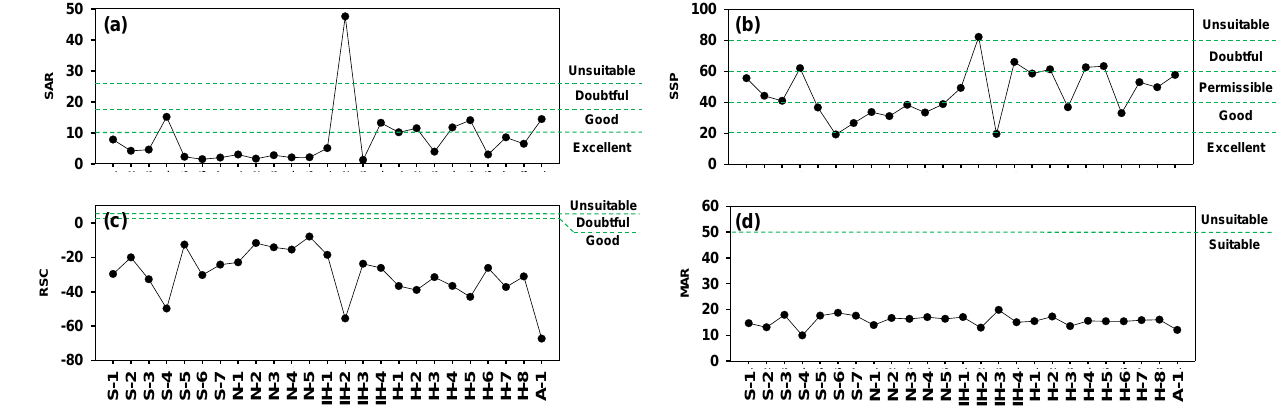
Figure 5. Water quality assessment for irrigation water ( a ) sodium absorption ratio (SAR), ( b ) soluble sodium percentage (SSP), ( c ) residual sodium carbonate (RSC), and ( d ) magnesium adsorption ratio (MAR) in Han River watershed.